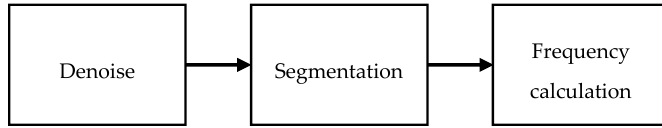
Figure 6. The procedure for data processing.